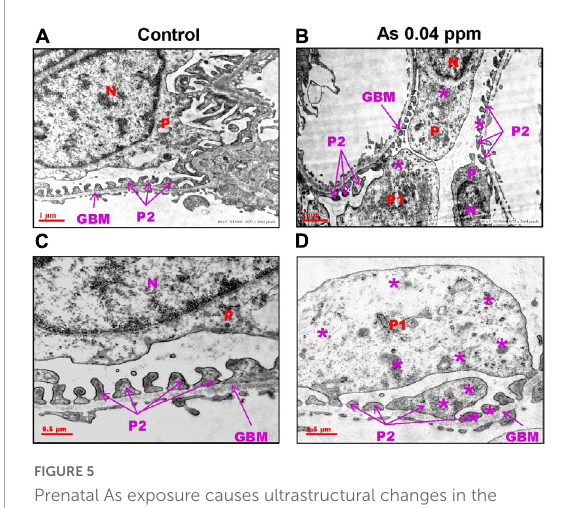
FIGURE5 Prenatal As exposure causes ultrastructural changes in the glomerulus which is reflected in the abnormal expression pattern of podocin (NPHS2). Prenatal As exposure leads to swollen, extended (P1), and damaged foot processes (P2) (B–D) as compared with the control (A–C) as observed in the TEM sections of kidney isolated from 38-week-old offspring. The podocytes (P) extend branching foot processes (P1 and P2) which lie around the glomerular basement membrane (GBM). The asterisk represents the site of damage in P1 and P2 (A–D) .